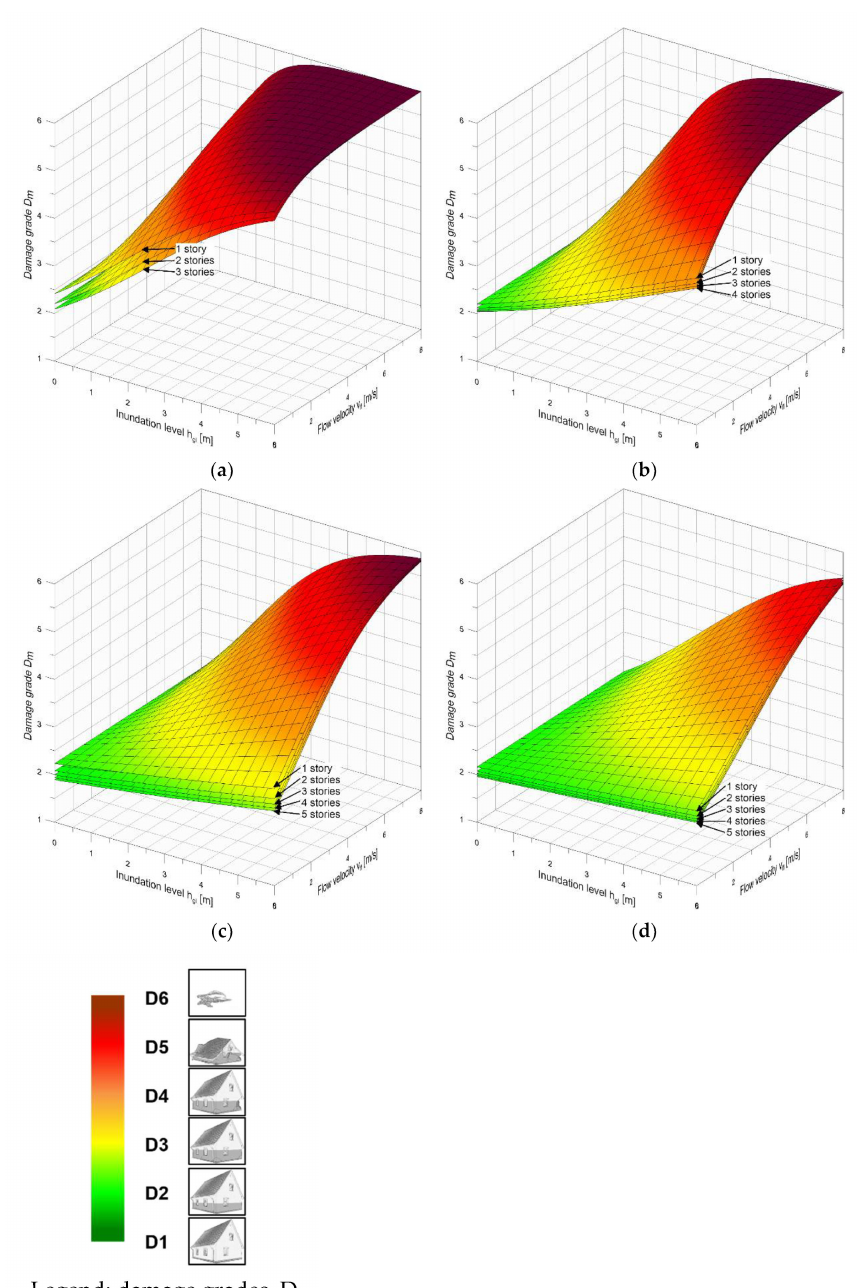
Figure 9. Vulnerability functions (variant V2) depending on inundation level ( h gl ), flow velocity ( v fl ) and number of storeys ( n st ): ( a ) HW-A; ( b ) HW-B; ( c ) HW-C; ( d ) HW-D (variant V3 is shown in